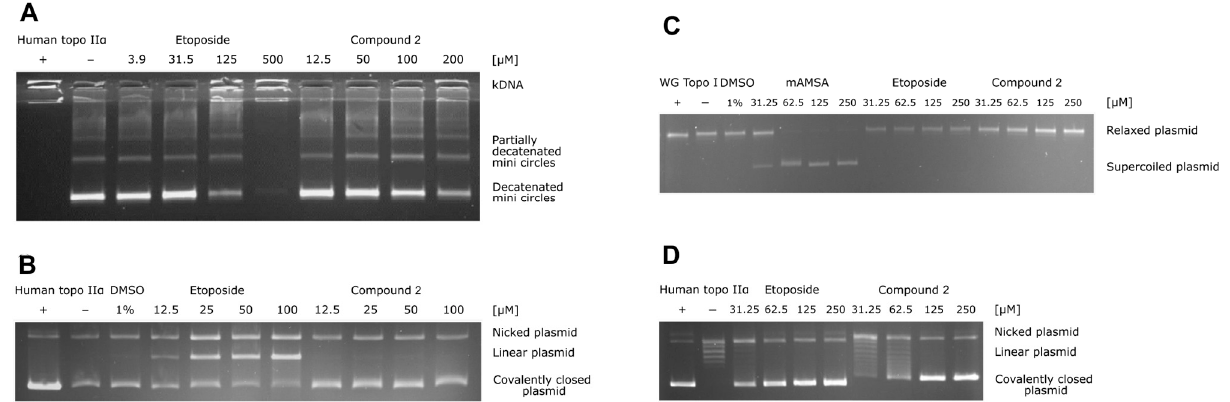
Figure 3. ( A ) Results of the human topo II α -mediated decatenation assay. The assay was performed for four different concentrations of compound 2 (12.5, 50, 100, and 200 µM) and for etoposide as a positive control (3.9, 31.5, 125, and 500 µM). ( B ) Human topo II α -mediated cleavage assay. The assay was performed for four different concentrations of compound 2 (12.5, 25, 50, and 100 µM), and etoposide was used as a positive control (12.5, 25, 50, and 100 µM). ( C ) Unwinding assay using supercoiled substrate. The assay was performed for four different concentrations of compound 2 and etoposide (31.5, 62.5, 125, and 250 µM) and of the positive control intercalator mAMSA (31.5, 62.5, 125, and 250 µM). ( D ) Results of the topoisomerase II α -mediated relaxation assay. The assay was performed for four different concentrations of compound 2 (31.5, 62.5, 125, and 250 µM) and etoposide as positive control (31.5, 62.5, 125, and 250 µM).